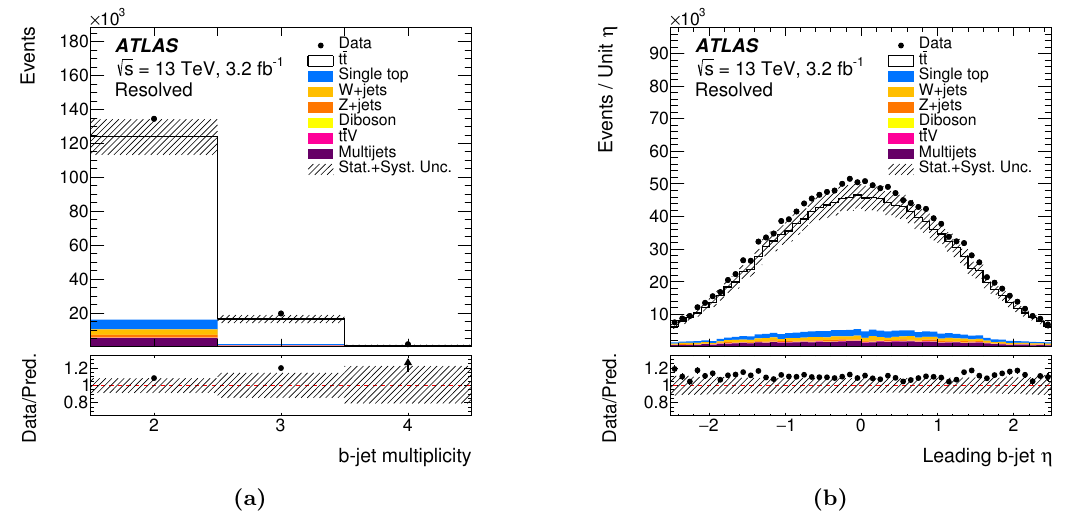
Figure 2. Kinematic distributions in the combined ‘ +jets channel in the resolved topology at detector level: (a) number of b -tagged jets and (b) leading b -tagged jet (cid:17) . Data distributions are compared to predictions using Powheg + Pythia6 as the t (cid:22) t signal model. The hatched area indicates the combined statistical and systematic uncertainties in the total prediction, excluding systematic uncertainties related to the modelling of the t (cid:22) t system. Events (below) beyond the range of the horizontal axis are included in the ((cid:12)rst) last bin.